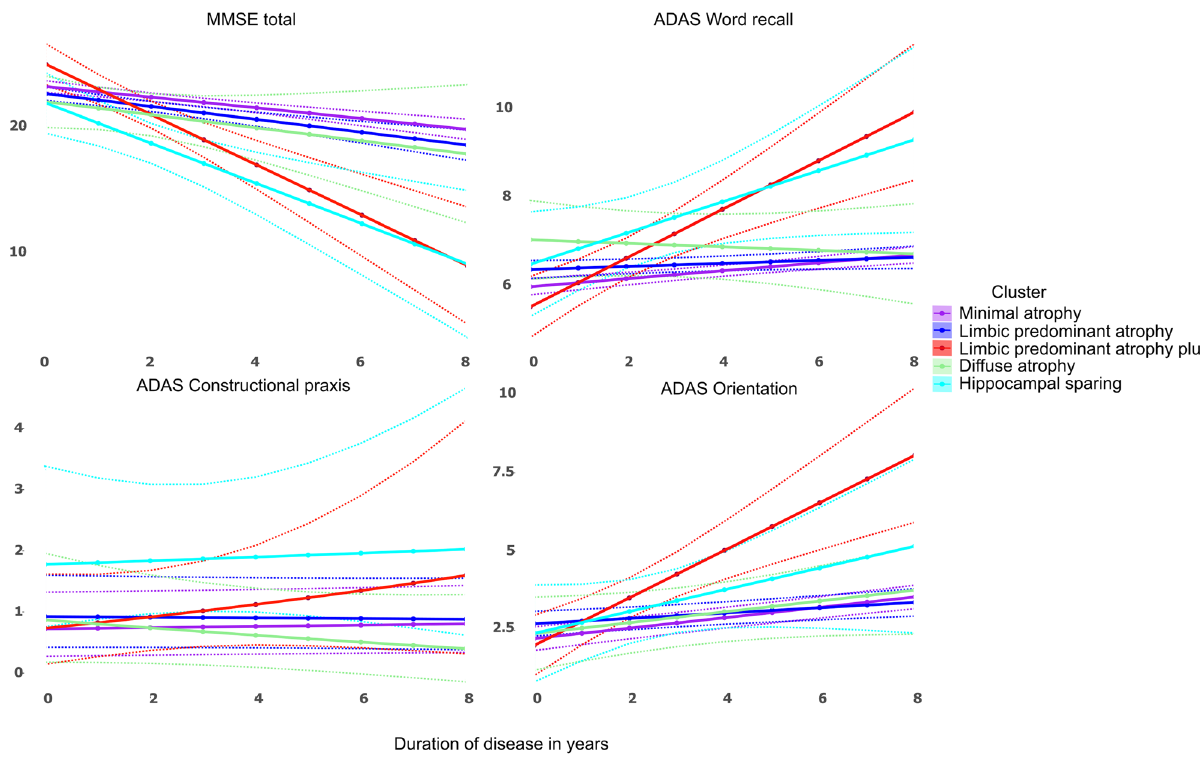
Alzheimer ’ s disease assessment scale. Dotted lines represent 95% con fi dence intervals.